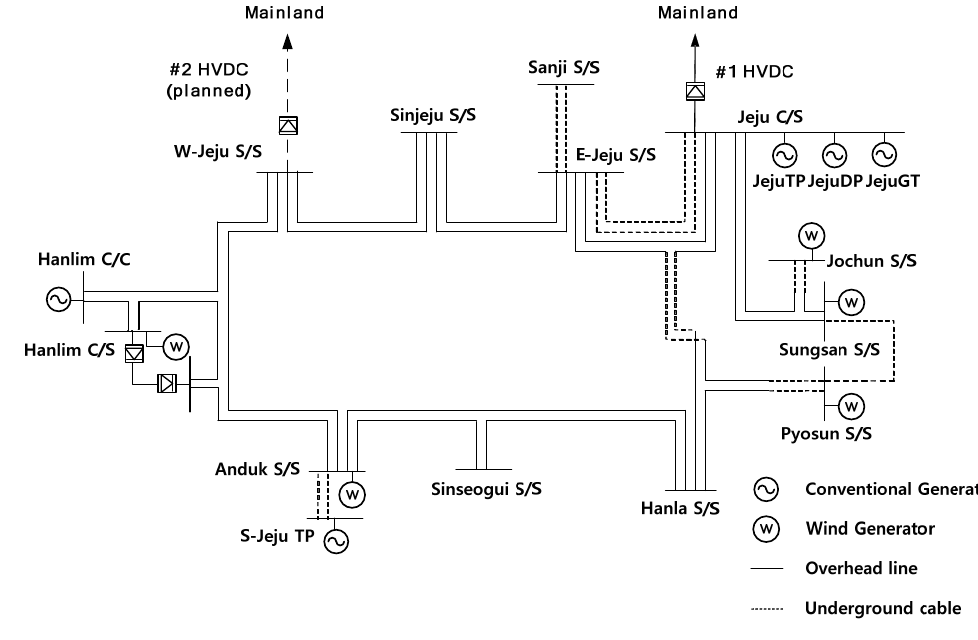
Figure 4. Jeju Island power system diagram.